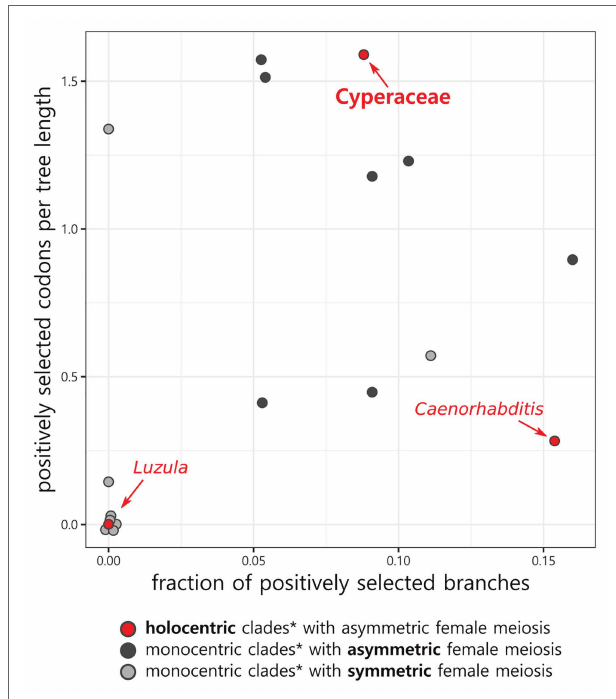
FIGURE 3 | Fraction of positively selected branches and number of positively selected codons relative to the tree length in CenH3 in Cyperaceae and other groups. Jitter has been applied to the data points to differentiate the overlapping points at the origin. *More detailed information on genera, families, and is listed in Table 1